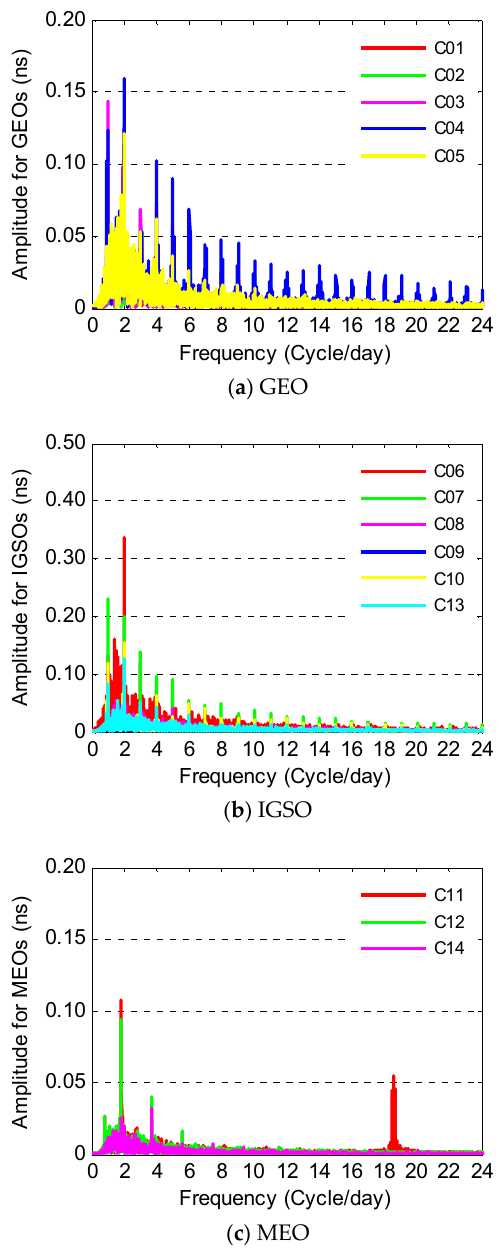
Figure 4. Frequency analysis for BeiDou satellite navigation system (BDS)-2 clocks.